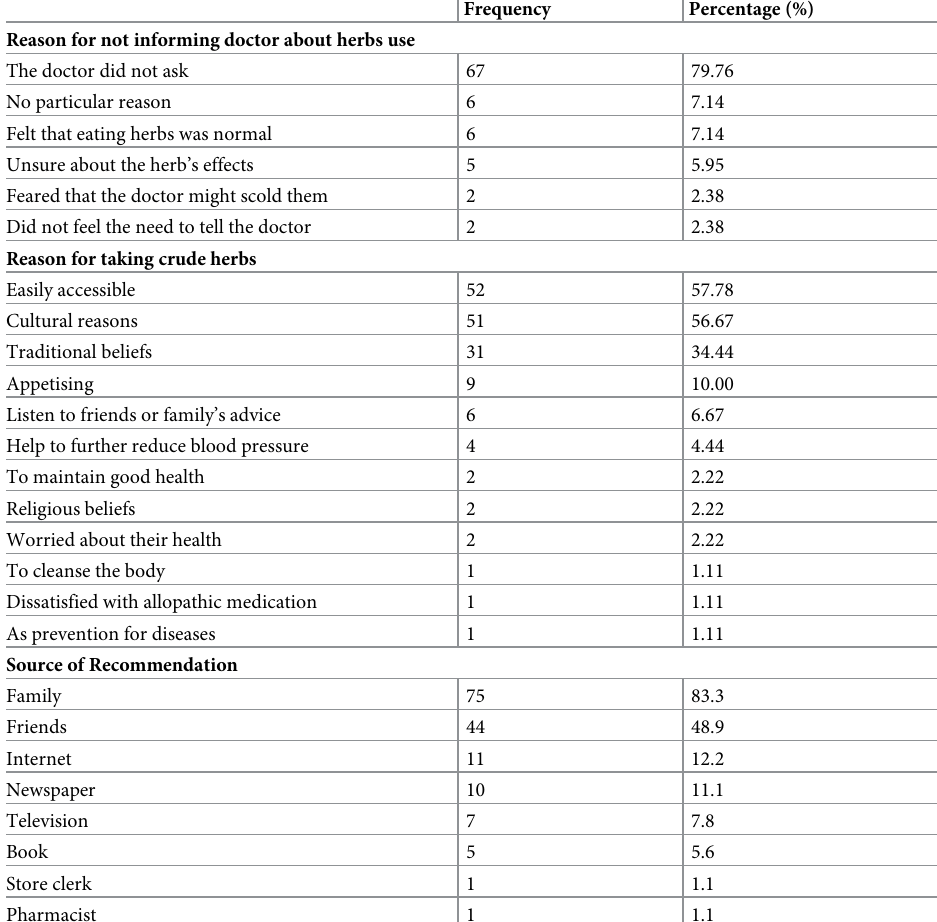
Table 4. Patient’s reason for not informing doctor about herbs usage, reason for taking crude herbs and sources of